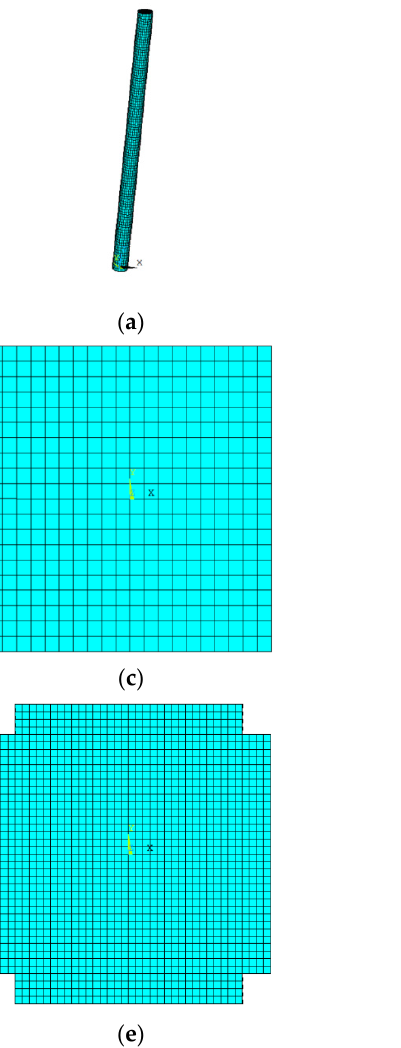
λ ); ( c ) initial model of planar λ ); ( e ) initial model λ ).